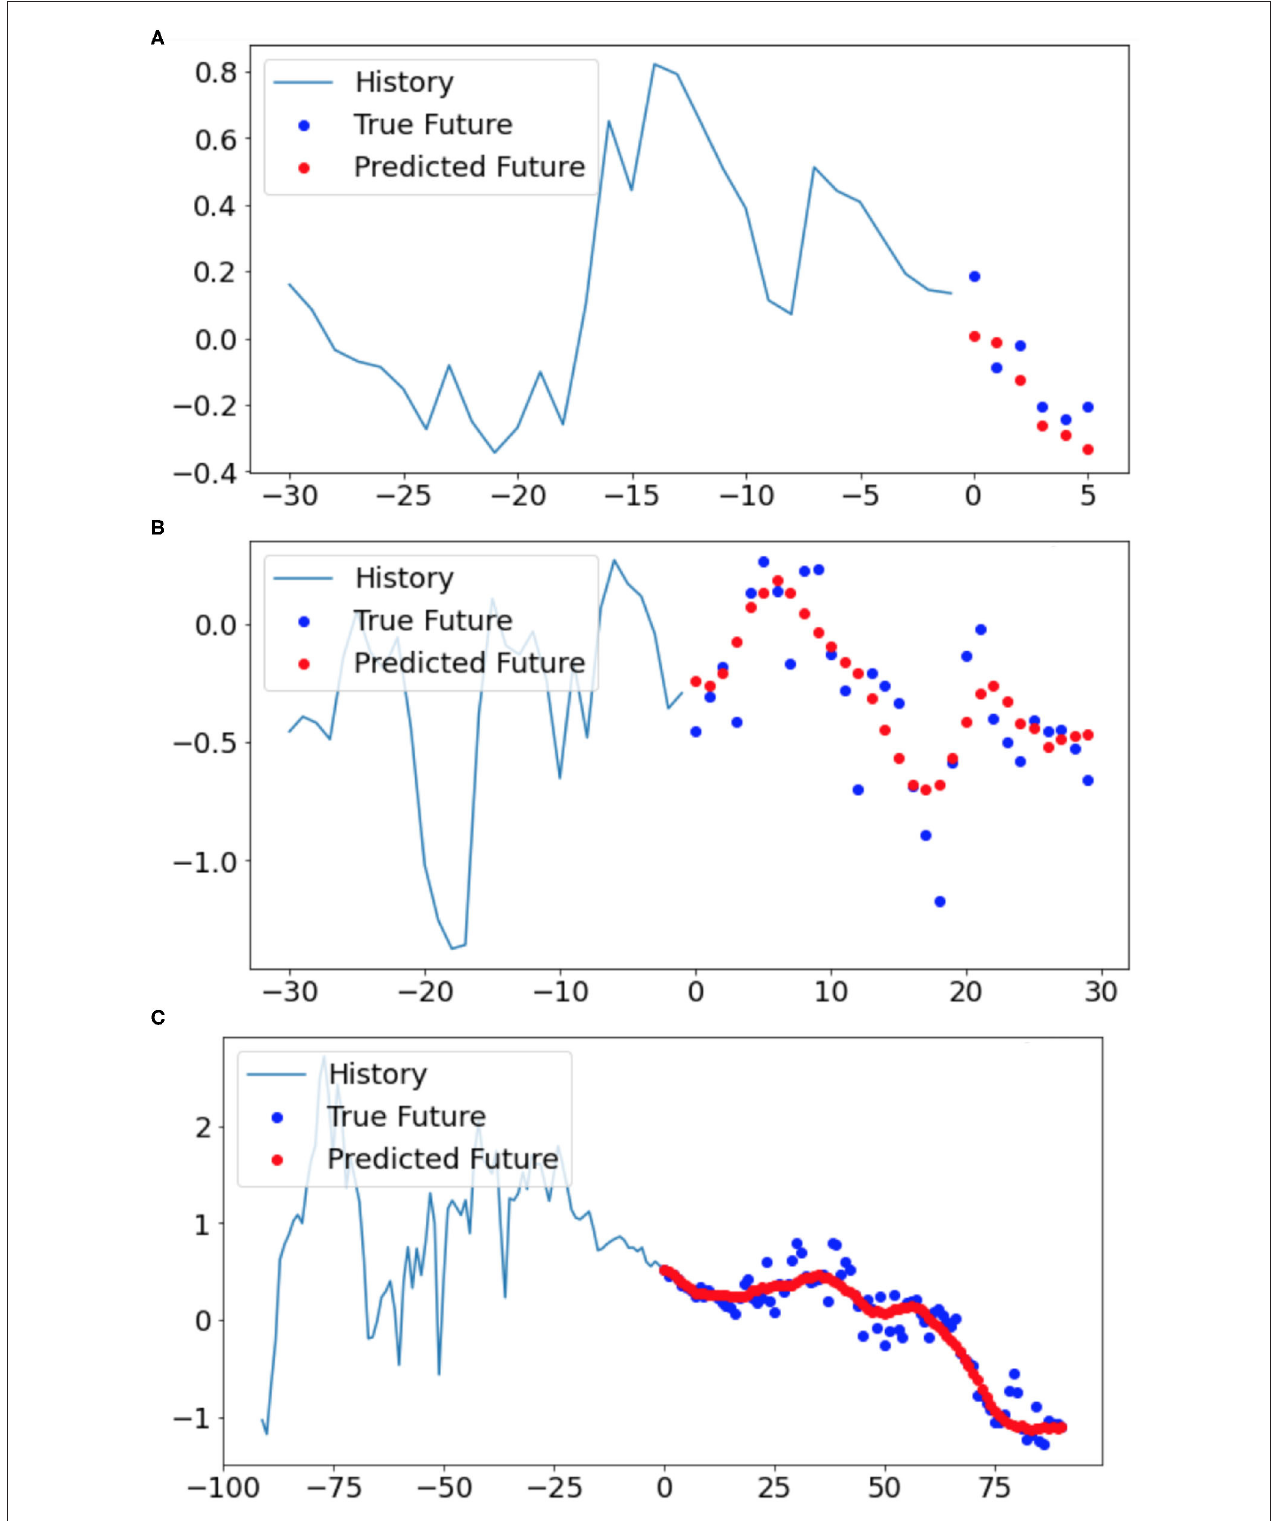
FIGURE 10 | Three samples of the model filled gaps from the validation dataset based on (A) model 1, (B) model 2, and (C) model 3, respectively. The blue lines show the 30, 30, and 90-day history timeseries (normalized units) which were used as input for the LSTM models 1, 2, and 3, respectively. The blue points demonstrate the observed temperatures whereas the red points indicate the model predicted temperatures over the next (A) 6, (B) 30, and (C) 91 days after the history window.